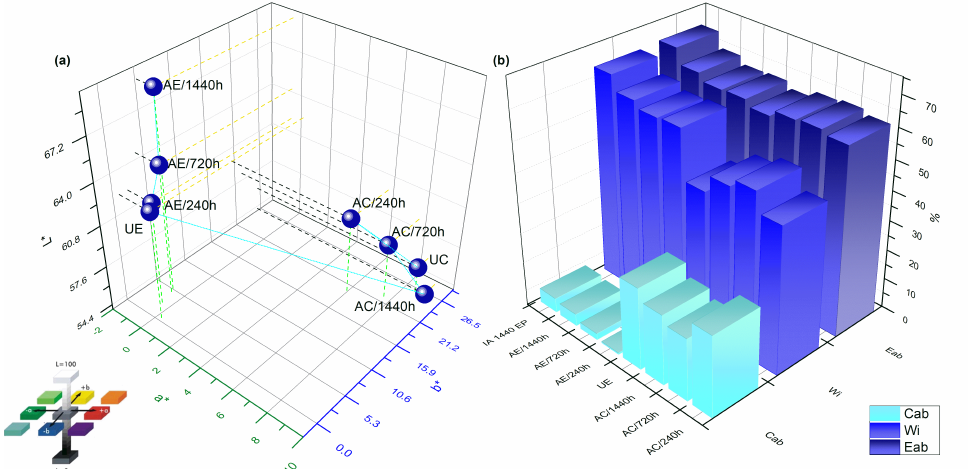
Figure 8. ( a ) Changes in color coordinates of the color space CIELAB for epoxy resin, composite and their ( b ) main parameters during water immersion aging.